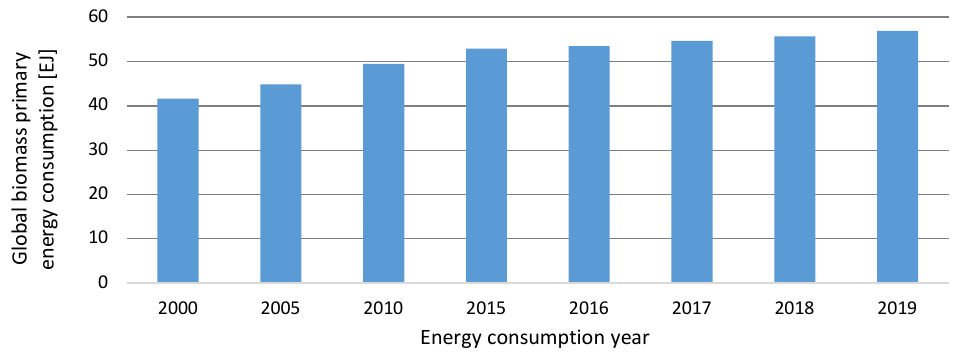
Figure 6. Global biomass primary energy consumption (2000–2019) [29].